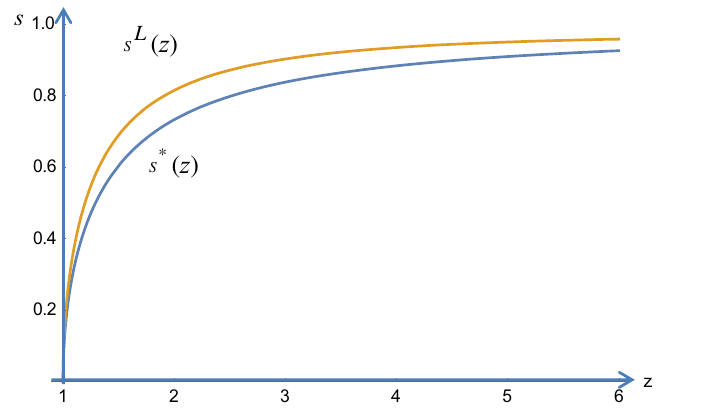
Fig. 9 Largest size of the buyer group that satisfies participation constraints (B8) and (B10) compared with the size that maximizes the per-member consumer surplus, for different values of parameter